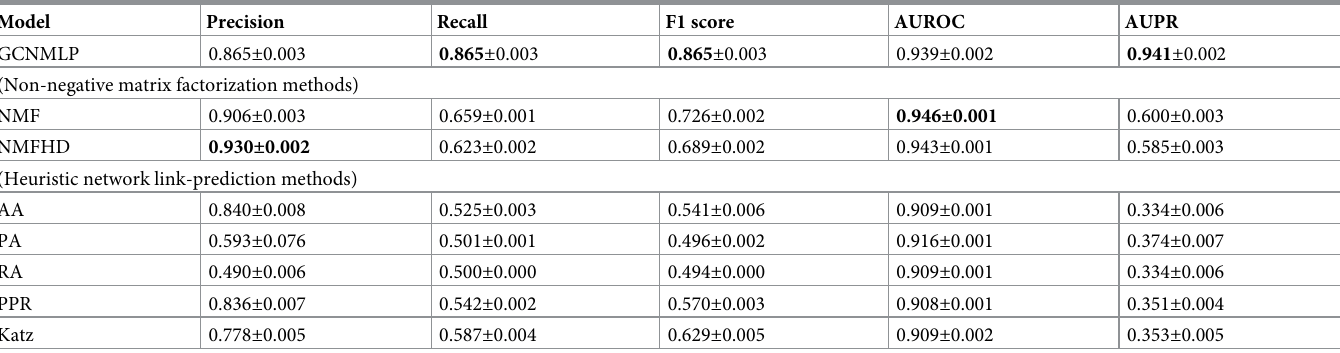
Table 5. Comparing the performance of various algorithms.